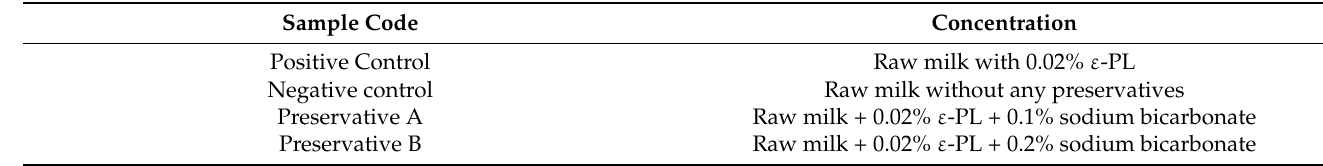
Table 1. Preservation studies of milk using 0.02% ε -PL along with various concentrations of sodium